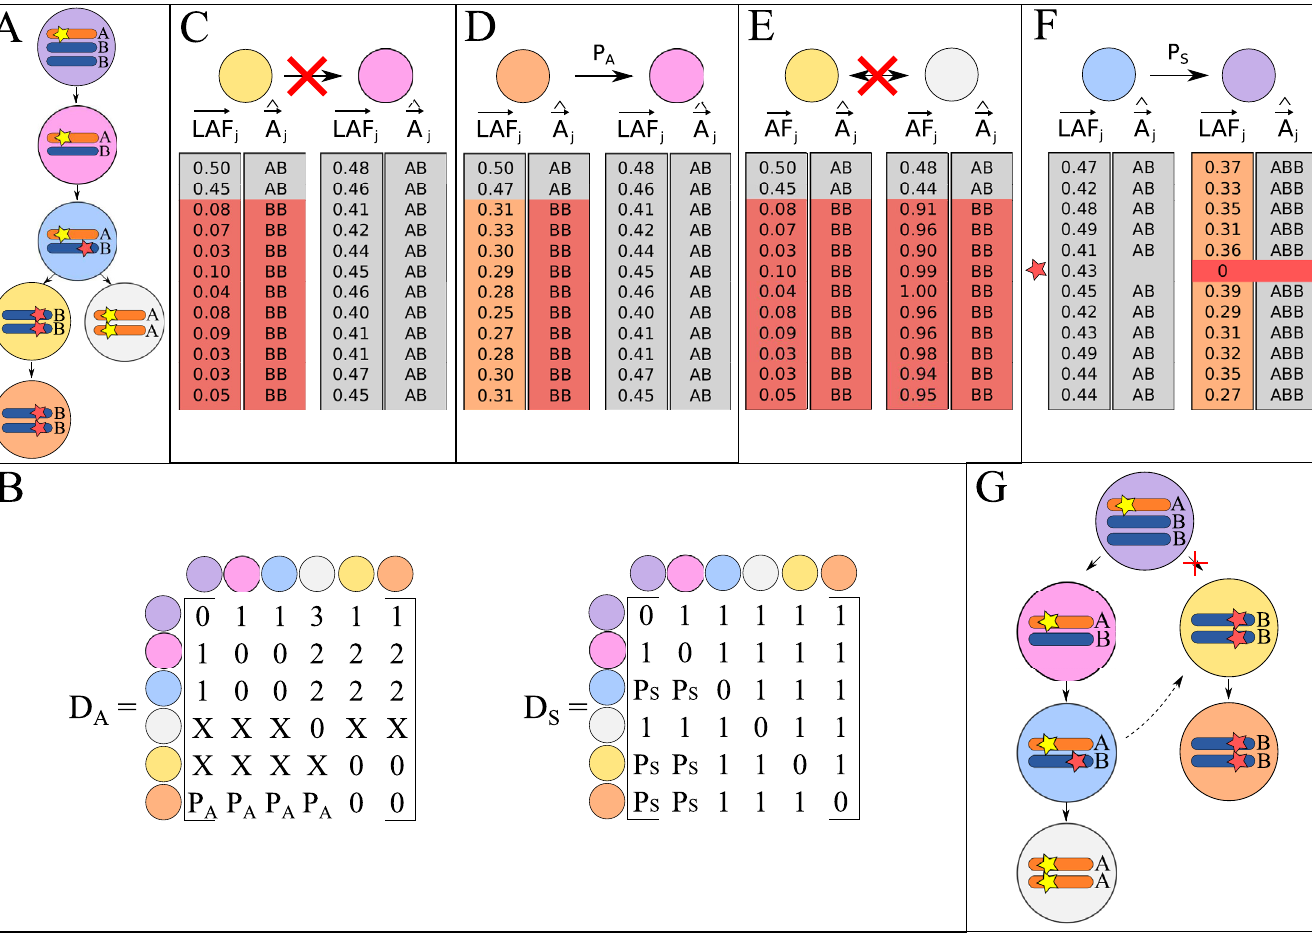
Fig 2. (A) Example of the true T for 6 hypothetical subclones. (B) Distance matrices reconstructed from the event distance based on alleles ( D A ) and somatic SNVs ( D S ). ‘X’ indicates that a subclone cannot be the parent of another subclone. (C) and (D) Edges can be restricted or penalized based on LOH. Each row in the matrix represents ^ ~ a measurement position on the genome. The measured LAF and the A inferred by TargetClone are shown in separate columns. A grey color represents a balanced situation, orange allelic imbalance, and red LOH. The first two measurements are not shown in the tree in panel (A). (E) If different parental alleles are lost, edges can be restricted. The ground truth alleles are AA in the grey subclone, but TargetClone will report the alleles as BB. (F) Edges can be penalized if the loss of somatic SNVs is unlikely. (G) Example of the MSA for the subclones shown in (A). The red cross indicates that an edge in the MSA is removed when resolving the ISA. The dashed line indicates a newly added edge after resolving the